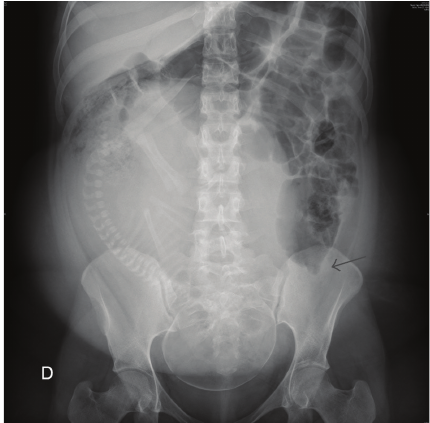
Figure 2: Abdominal X-ray showing dilatation of the small and large bowel loops. The arrow shows the stop at colon level. Displace- ment of the gravid uterus to the right is clearly seen.